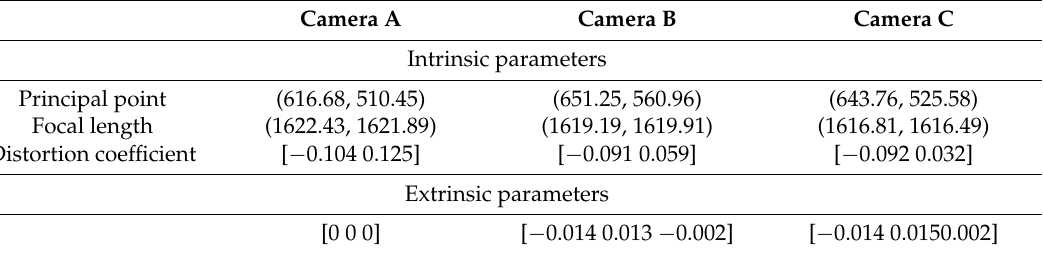
Table 1. Measured intrinsic and extrinsic parameters of the cameras.